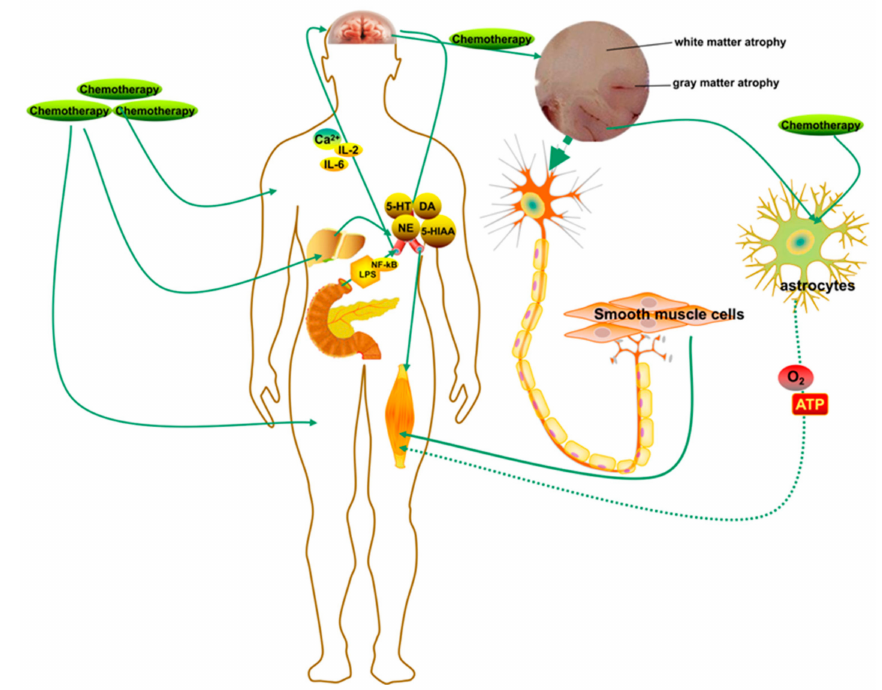
Figure 4. The central nervous system (CNS) integrates the signals from peripheral circulations to inhibit or amplify immune signals through neural regulation mechanisms. On the account of inflammatory stress, peripheral inflammatory cytokines enter the brain through various routes to activate microglia and astrocytes and to generate neurotoxins that cause neuroinflammation in the CNS. Furthermore, inflammation of the nervous system leads to severe disorders of systemic circulations, such as decreased blood-brain barrier (BBB) strength, atrophy of spinal gray matter, or decreased muscular innervation. A nervous system a ff ected by peripheral or central inflammatory responses is inclined to destroy muscle cells and inhibit the generation of energy and nutrition, leading to motor unit decrease and severe fatigue, both physical and